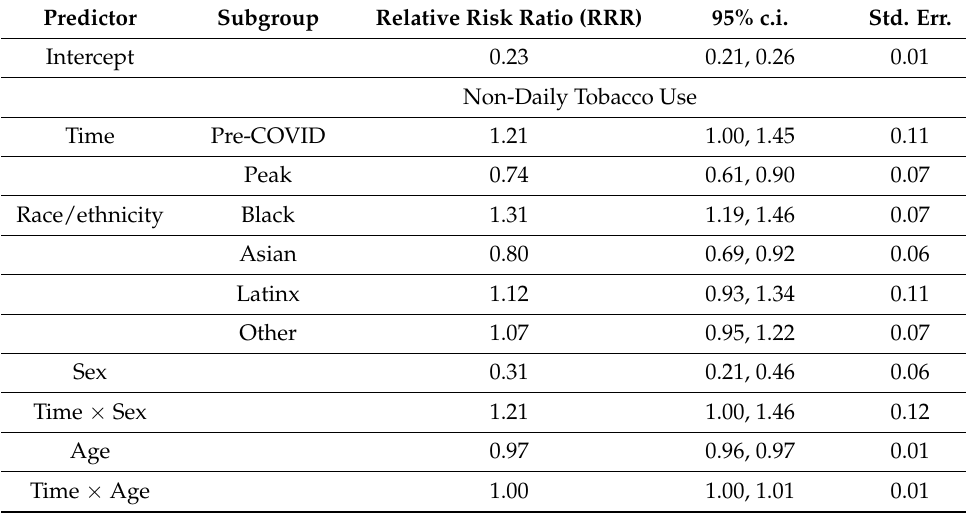
Table 2. Multinomial logistic regression model predicting tobacco use status for pre-COVID and peak COVID compared with early